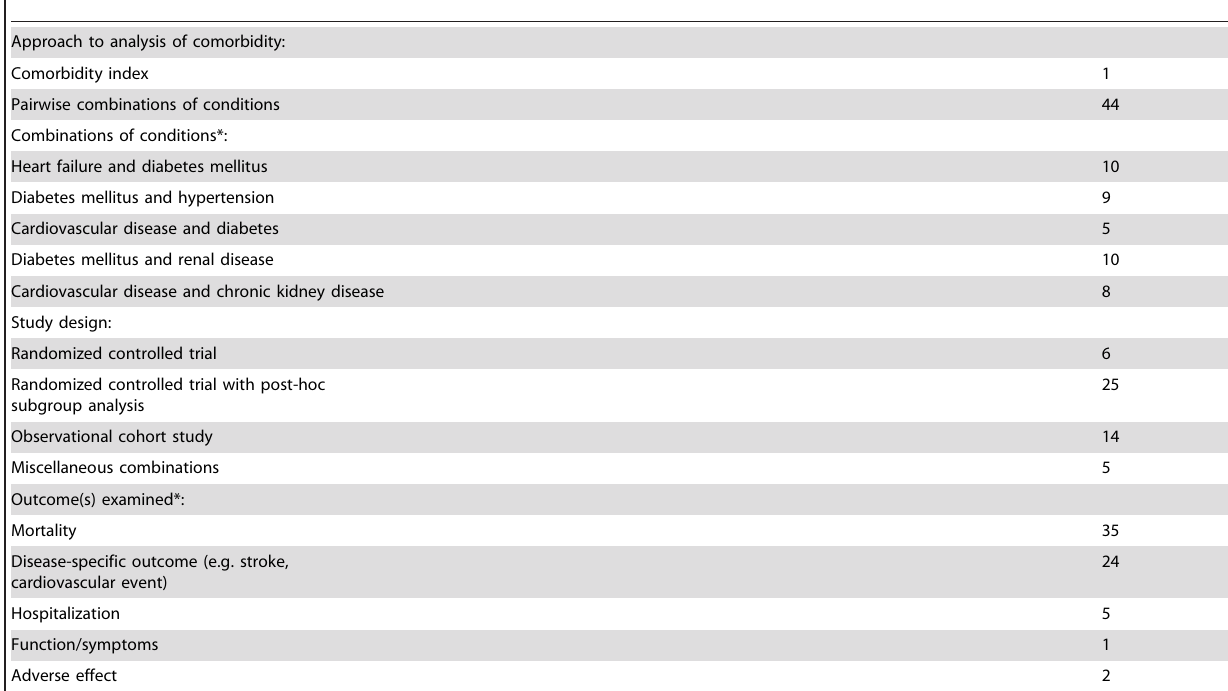
Table 1. Description of studies identified in systematic review.